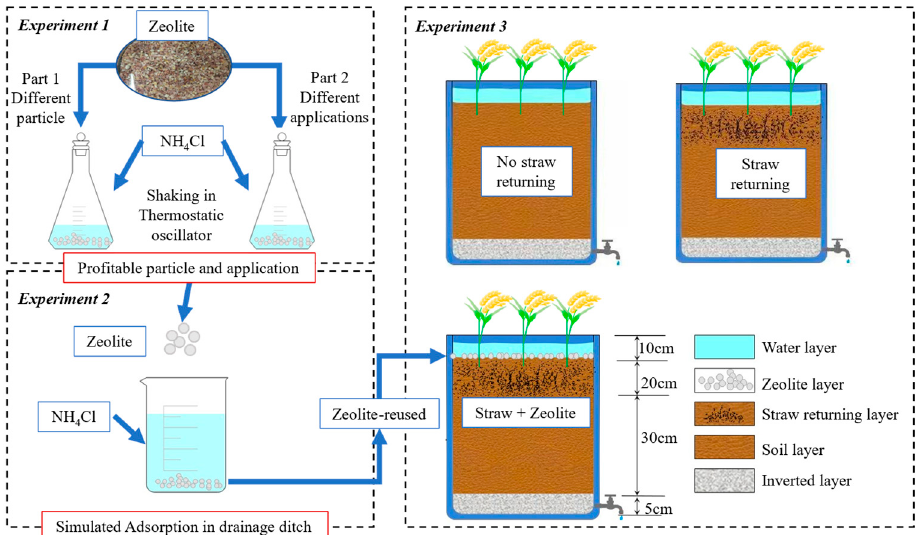
Figure 2. A schematic diagram of the experimental